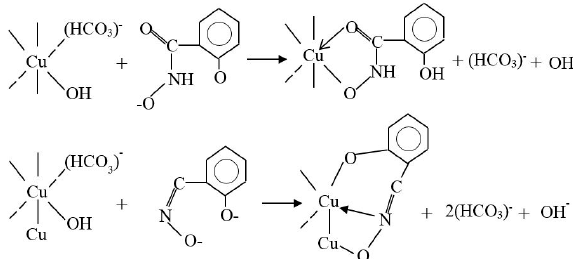
Figure 5. Schematic illustration of the adsorption of salicyl hydroxamate and salicylaldoxime on the malachite surface.